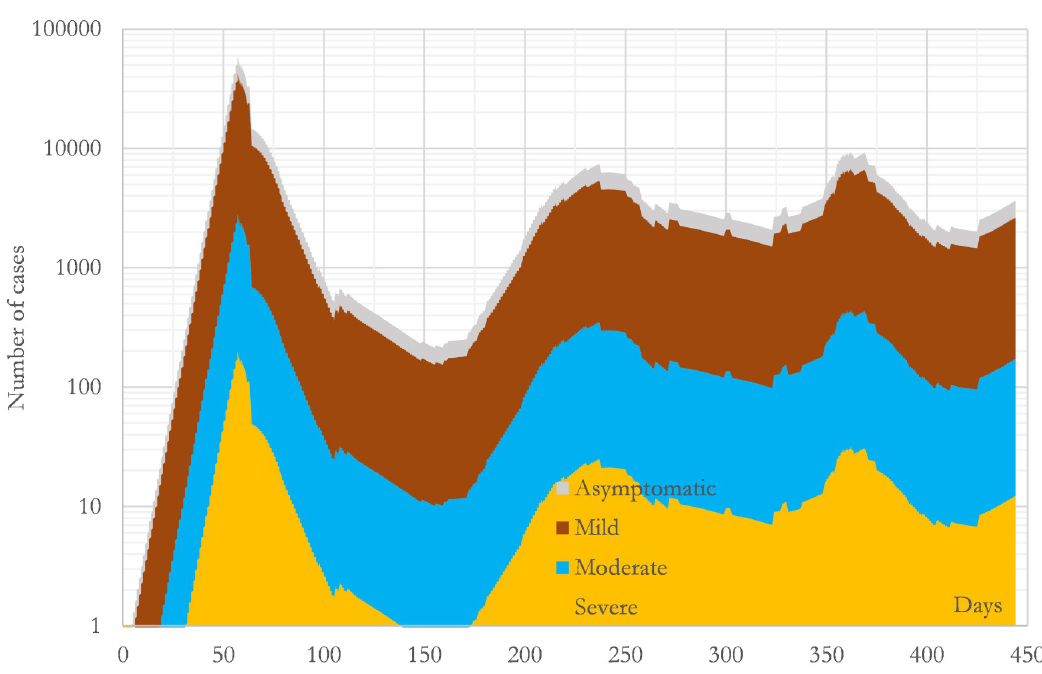
Fig 6. Calculated evolution of the incidence during the studied period in the region of Madrid (CM). The curves present the number of new daily infections which existed each day segregated by types. All the curves have been calculated with the convolution mathematical model presented in this study using the parameters collected in Table